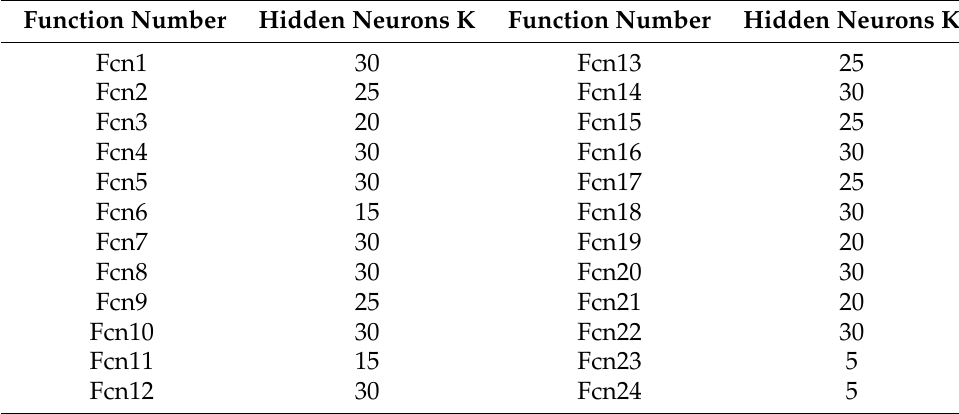
Table 2. The chosen ANN architecture for each objective function of